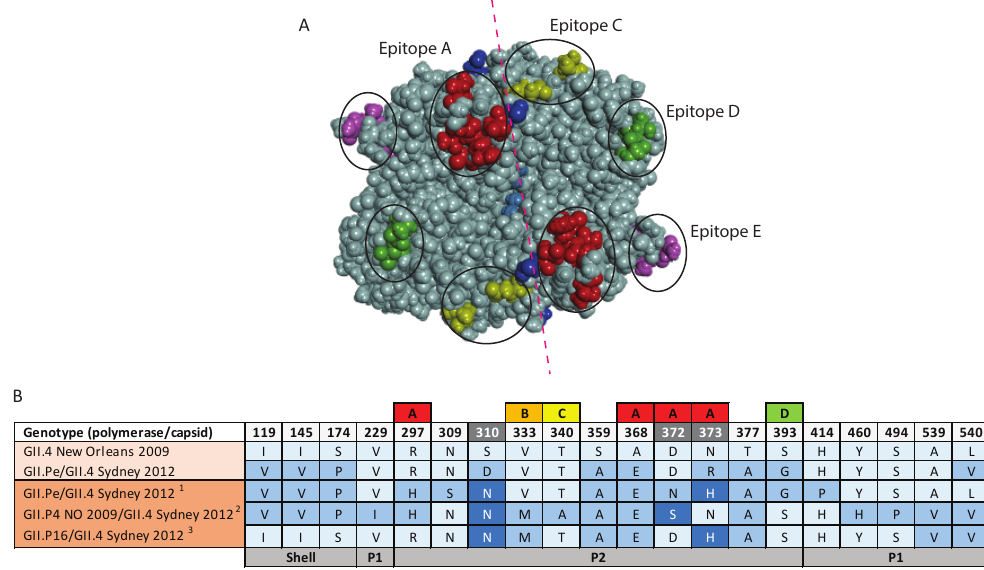
Figure 6. Capsid residue variation and antigenic variation within the full-length capsid of GII.4 recombinant viruses. Full-length capsid sequence of novel GII.4 recombinant viruses were collected between July 2014 and December 2017. Consensus sequences of contemporary GII.Pe/GII.4 Sydney 2012 1 ( n = 20), GII.4 New Orleans 2009/GII.4 Sydney 2012 2 ( n = 13) and GII.P16/GII.4 Sydney 2012 3 ( n = 9) were generated and compared to pandemic variants (New Orleans 2009 and Sydney 2012) for the identification of antigenic variations, especially within the P2 protruding domain. ( A ) Characterized blockade antibody epitopes are highlighted in the different colors; epitope A (red), epitope C (yellow), epitope D (green) and epitope E (purple). The residues within P2 domain, especially those within epitope A, which differed from the pandemic Sydney 2012 variant. The red dotted line shows symmetry. ( B ) Antigenic variations observed between full length capsid sequences of pandemic Sydney variant and the new Sydney 2012 recombinants. Labelled boxes above the antigenic sites indicate sites within known blockade epitopes A–D that are important determinants of viral antigenicity. The A–D